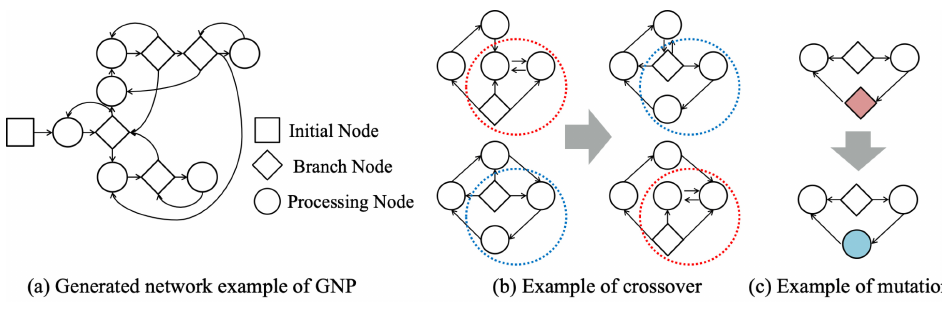
Figure 2. Example of genetic network programming